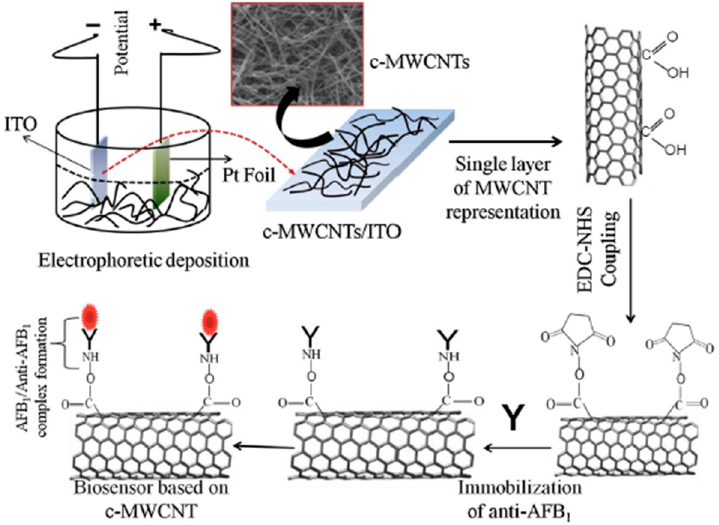
Figure 4. Schematic of MWCNT based biosensor for aflatoxin B1 detection [37].